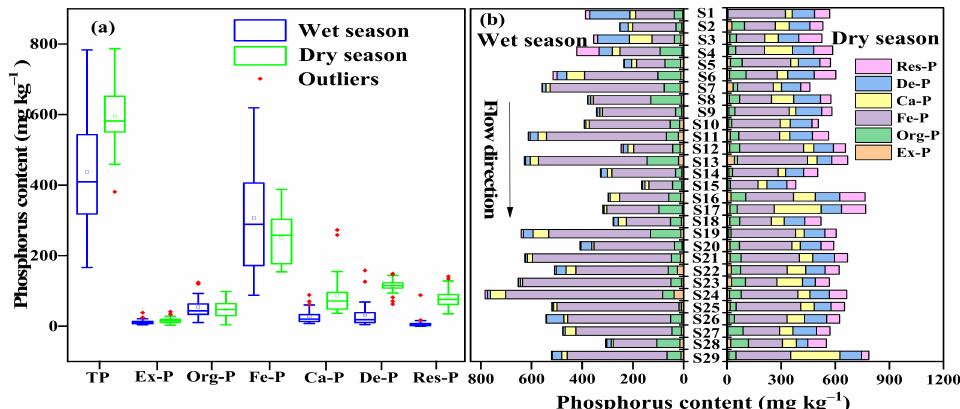
Figure 4. Phosphorus fractions distribution in different seasons ( a ) and sampling sites ( b ) in the sediment of the Tuojiang River (S1–S29 are defined in Figure